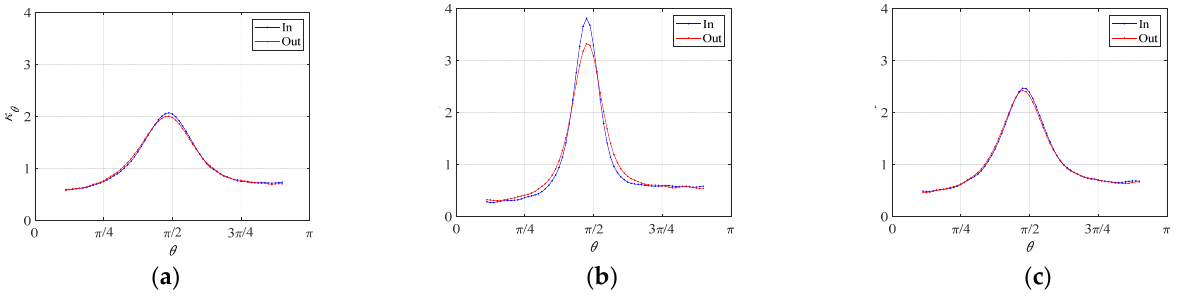
Figure 9. Curvature at bubble surface: ( a – c ) are under same conditions as those in Figure 8.